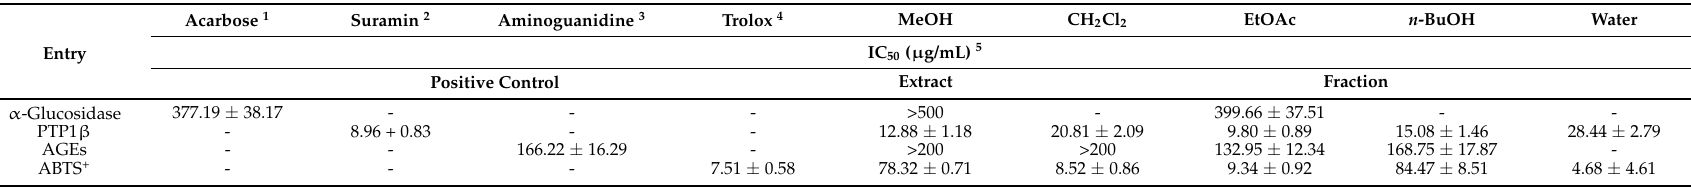
Table 2. Inhibitory effect of the crude extract and fractions of X. strumarium on α -glucosidase, protein tyrosine phosphatase 1 β (PTP1 β ), advanced glycation end products (AGEs), and ABTS +